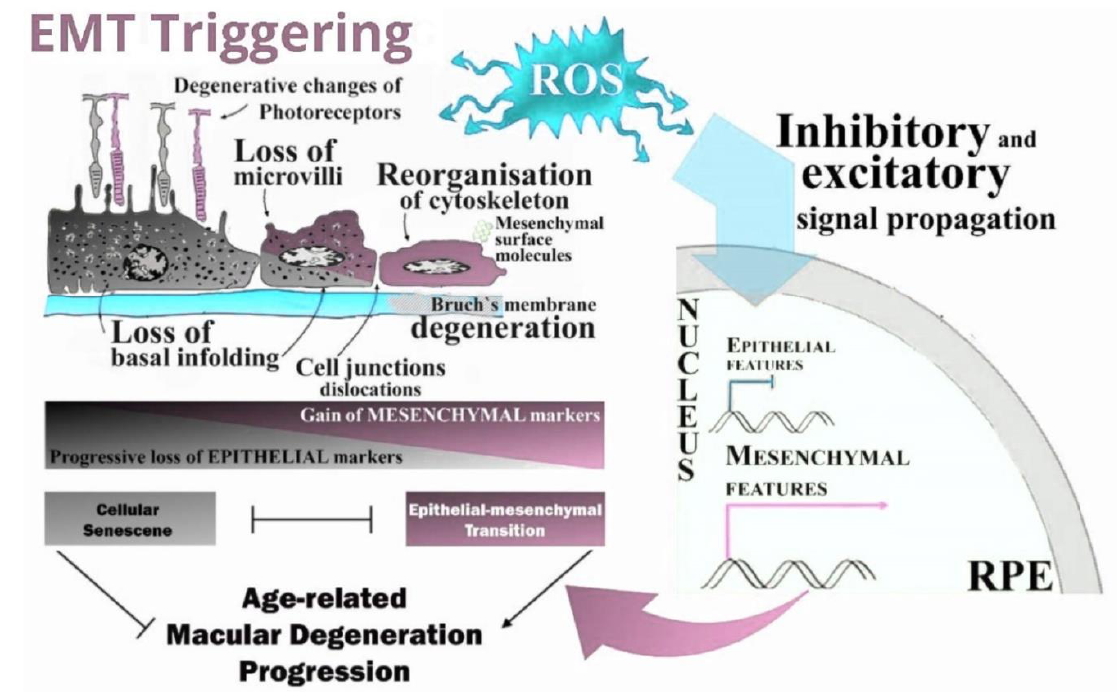
Figure 8. ROS-induced EMT-triggered signal propagation and transduction: an intricate interplay in the RPE of NFE2L2 / PGC-1α double knockout model enhances epithelial-mesenchymal transition (EMT). Simplified representation of the oxidative stress (OS)-dependent major molecular mechanisms of EMT. Reprogramming of gene expression during EMT, and non-transcriptional changes, are initiated and controlled by signaling pathways that respond to extracellular cues. Here, the arrows pointing from the signaling routes to the EMT transcription factors in the nucleus are grouped. EMT involves a functional transition of highly polarized retinal epithelial cells into ECM component-secreting mesenchymal-type flattened cells. Identification of all mesenchymal cells originating from the RPE via EMT is hardly possible as many mesenchymal cells display some epithelial markers while a transition is not fully completed.